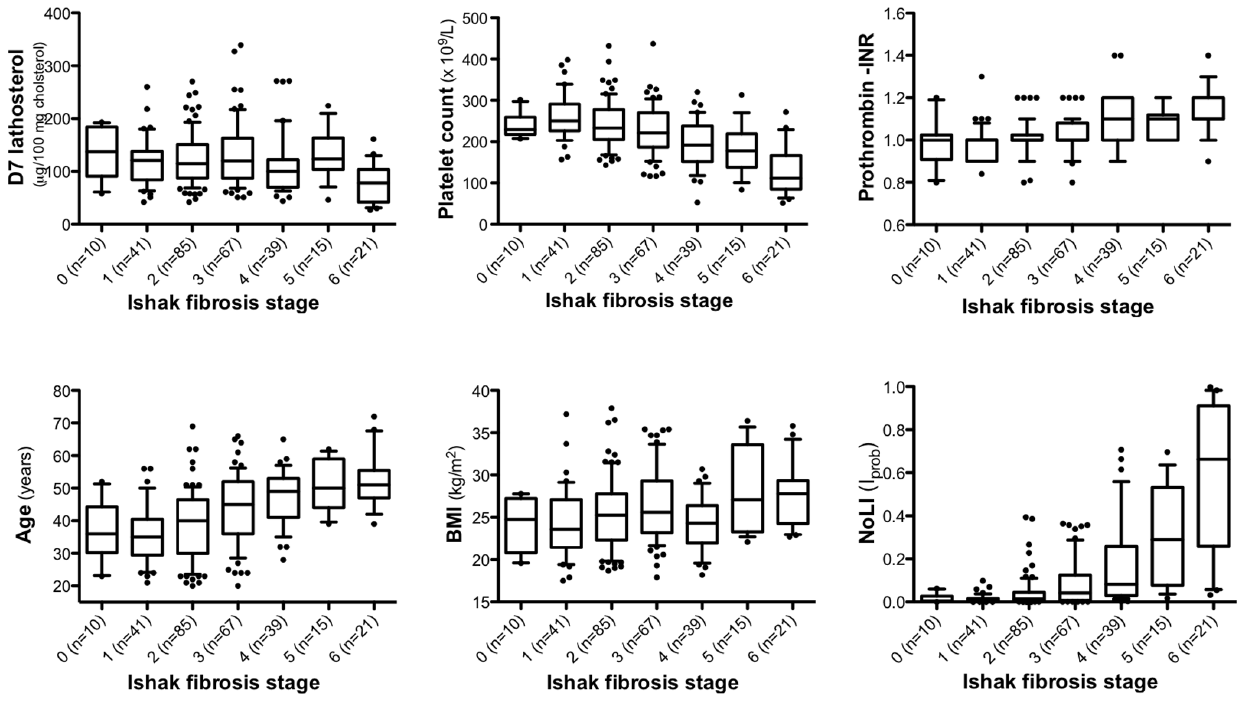
Figure 1. Box-plots displaying the different components of the NoLI index (D 7 lathosterol, platelet count, Prothrombin complex- INR, age and BMI) and the NoLI index in relation to Ishak fibrosis stage.